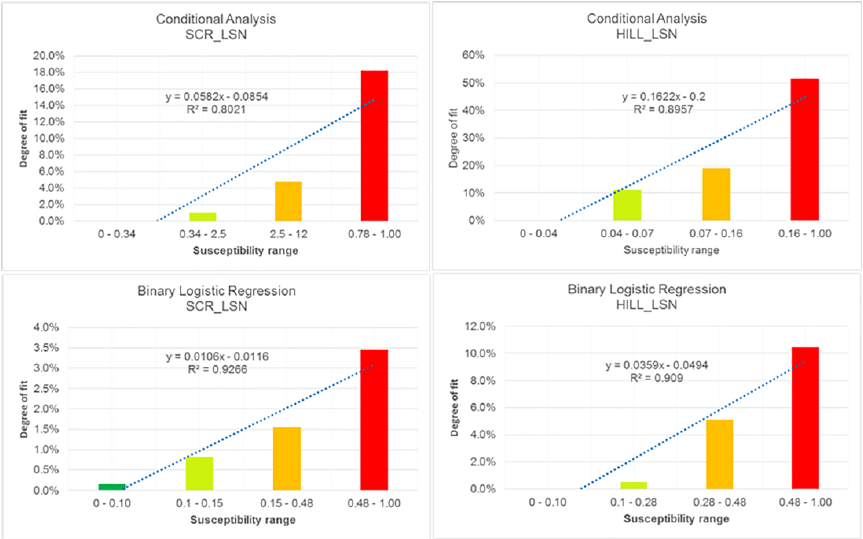
Figure 7. Distribution of landslides by susceptibility classes.